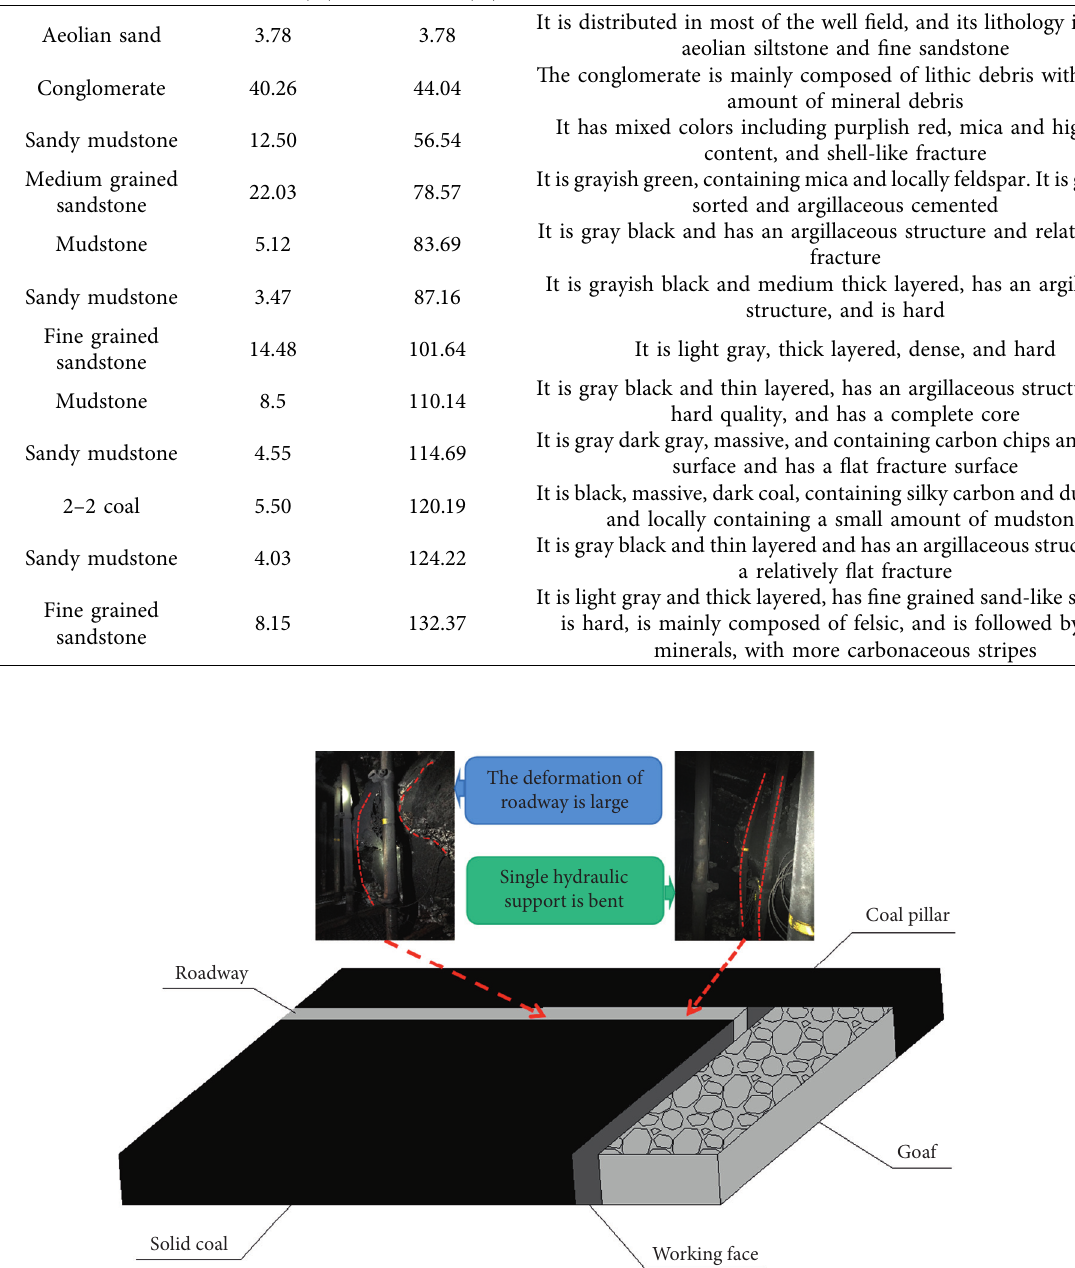
Figure 1: Working face site